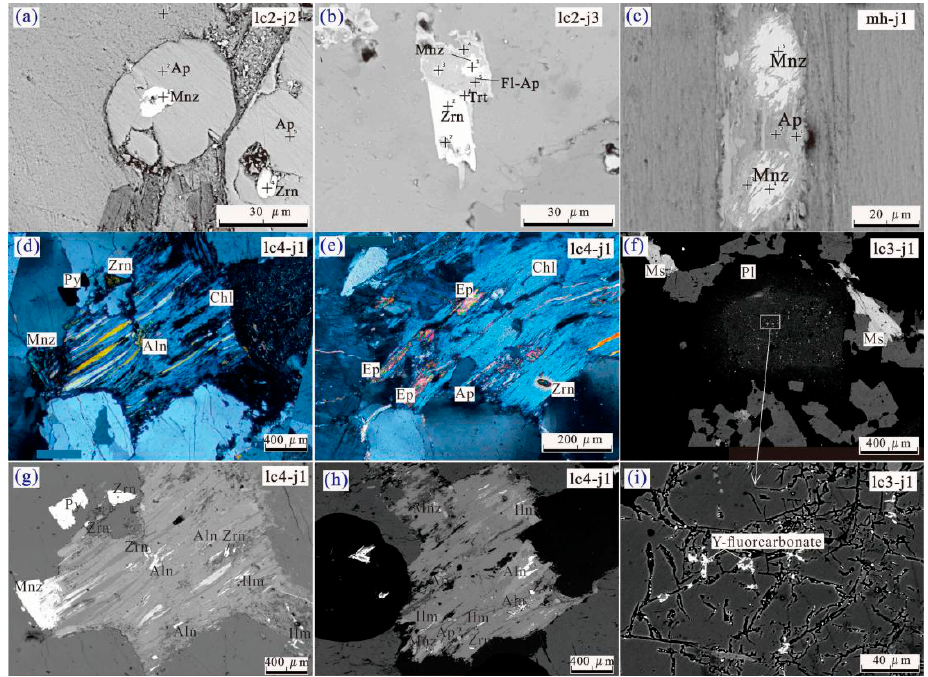
Figure 3. Optical ( d , e ) and back scattered electron (BSE, a – c and f – i ) images of REE minerals in the host Fig.3 BSE image of REE minerals in the host rock of QN iRee deposit ： (a)&(c) monazite and zircon occurs as anhedron associated with apatite; (b) monazite and thorite occurs as anhedron associated with fluorapatite; (d)&(g) monazite, allanite zircon occurs as rock of QN and MH iRee deposit: ( a , c ) monazite and zircon occur as anhedron associated with apatite; inclusion associated with biotite which artered to chlorite; (e)&(h) apatite and zircon occurs as euhedron associated with biotie ( b ) monazite and thorite occur as anhedron associated with fluorapatite; ( d , g ) monazite and allanite which altered to chlorite; (f)&(i) Y-fluorapatite occurs as anhedron filled into the interspace of feldspar; Mnz － Monazite; Xtm － zircon occur as subhedral—anhedral associated with biotite, which altered to chlorite; ( e , h ) apatite and Xenotime; Aln － Allanite; Ap － Apatite; Fl-Ap － Fluorapatite; Trt － Thorite ; Zrn － Zircon; Fl － Fluorite zircon occur as euhedron associated with biotie, which altered to chlorite; ( f , i ) Y-fluorapatite occurs as anhedron filled into the interspace of feldspar; Mnz—Monazite; Xtm—Xenotime; Aln—Allanite; Ap—Apatite; Fl-Ap—Fluorapatite; Trt—Thorite; Zrn—Zircon;